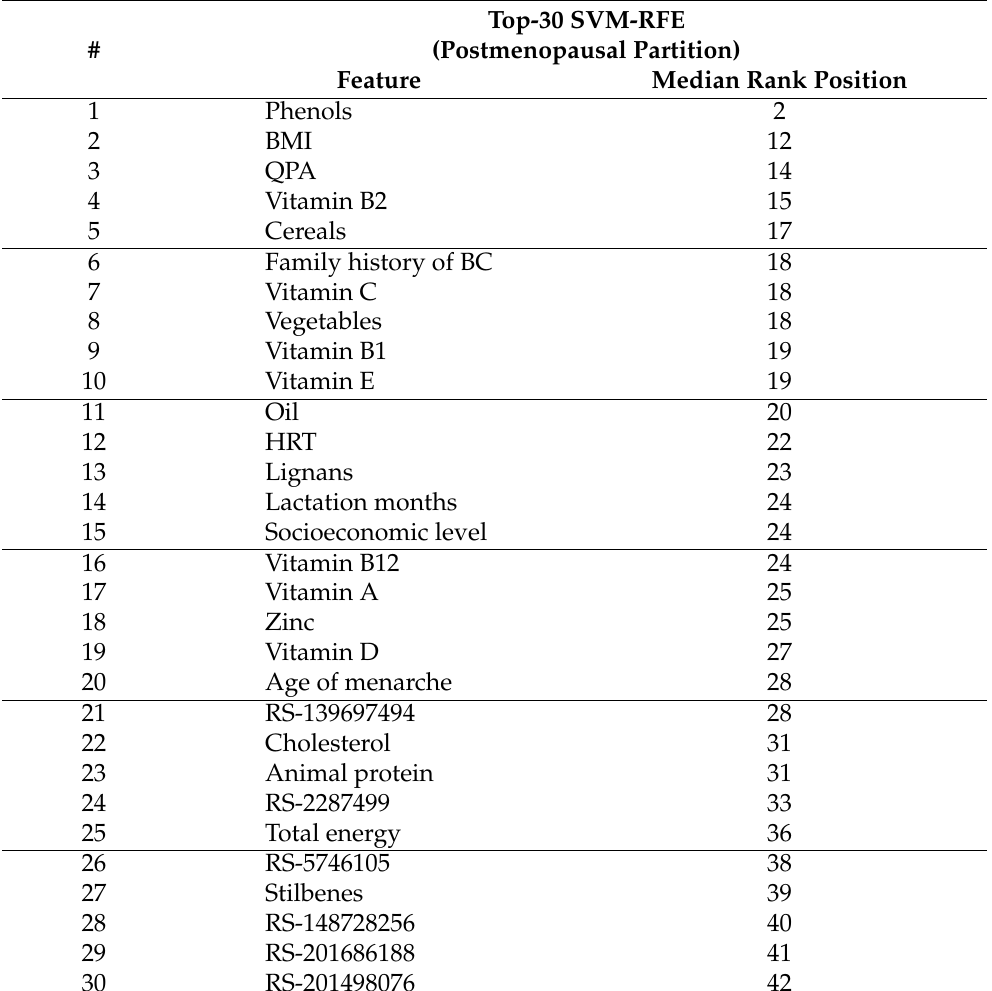
Table 15. Top-30 features of SVM-RFE ranking for postmenopausal data